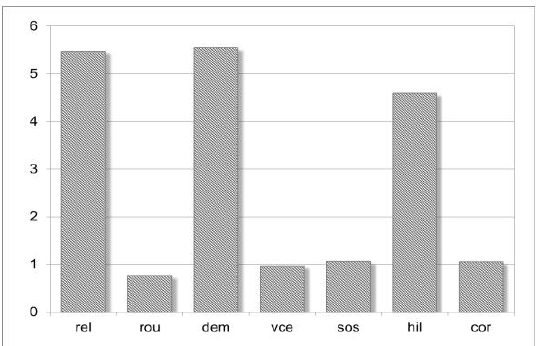
Figure 4. Each terrain factor importance measure Those values are rounded and then set to be the multiscale segmentation threshold for each layer. Segmentation threshold was set as 90 after repeated experiments.